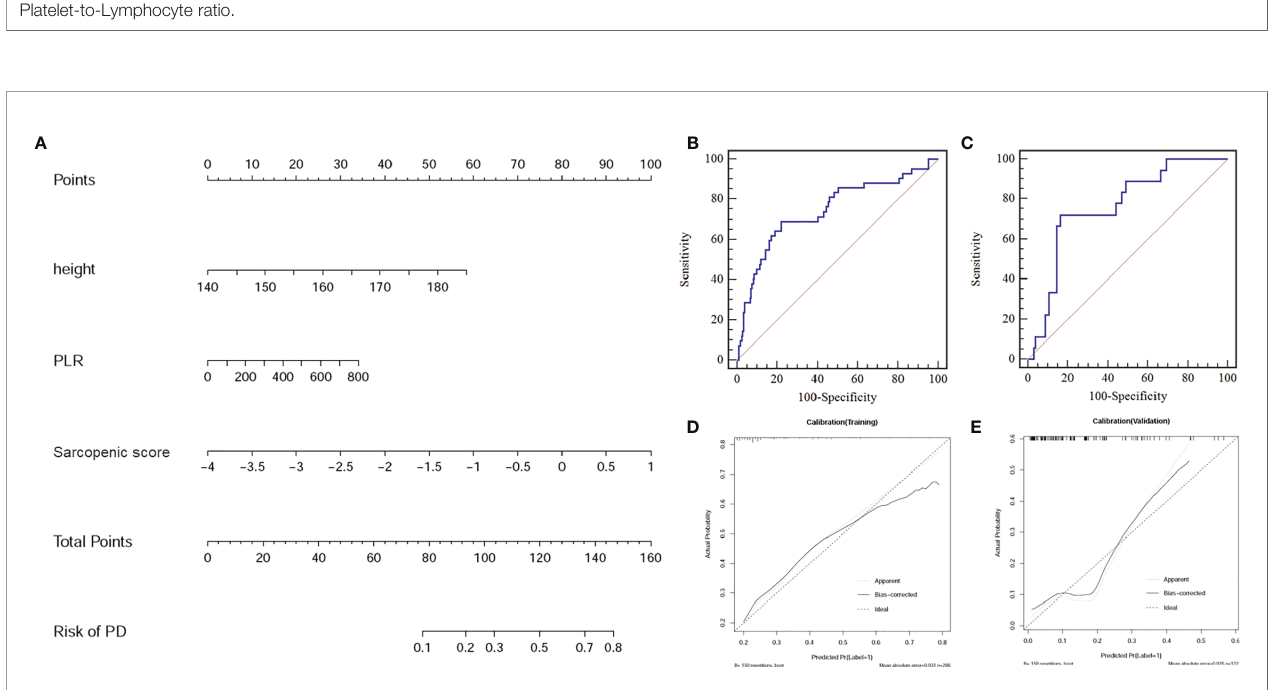
FIGURE 4 | (A) Sarcopenic nomogram constructed in the training cohort with the sarcopenic score, platelet-to-lymphocyte ratio (PLR), and body height. (B) The receiver operating characteristic (ROC) curve for the training cohort. (C) The ROC curve for the validation cohort. (D) Calibration curve of the sarcopenic nomogram in the training cohort. (E) Calibration curve of the sarcopenic nomogram in the validation cohort presenting the calibration of the predictive model for the risk of transition to progressive disease